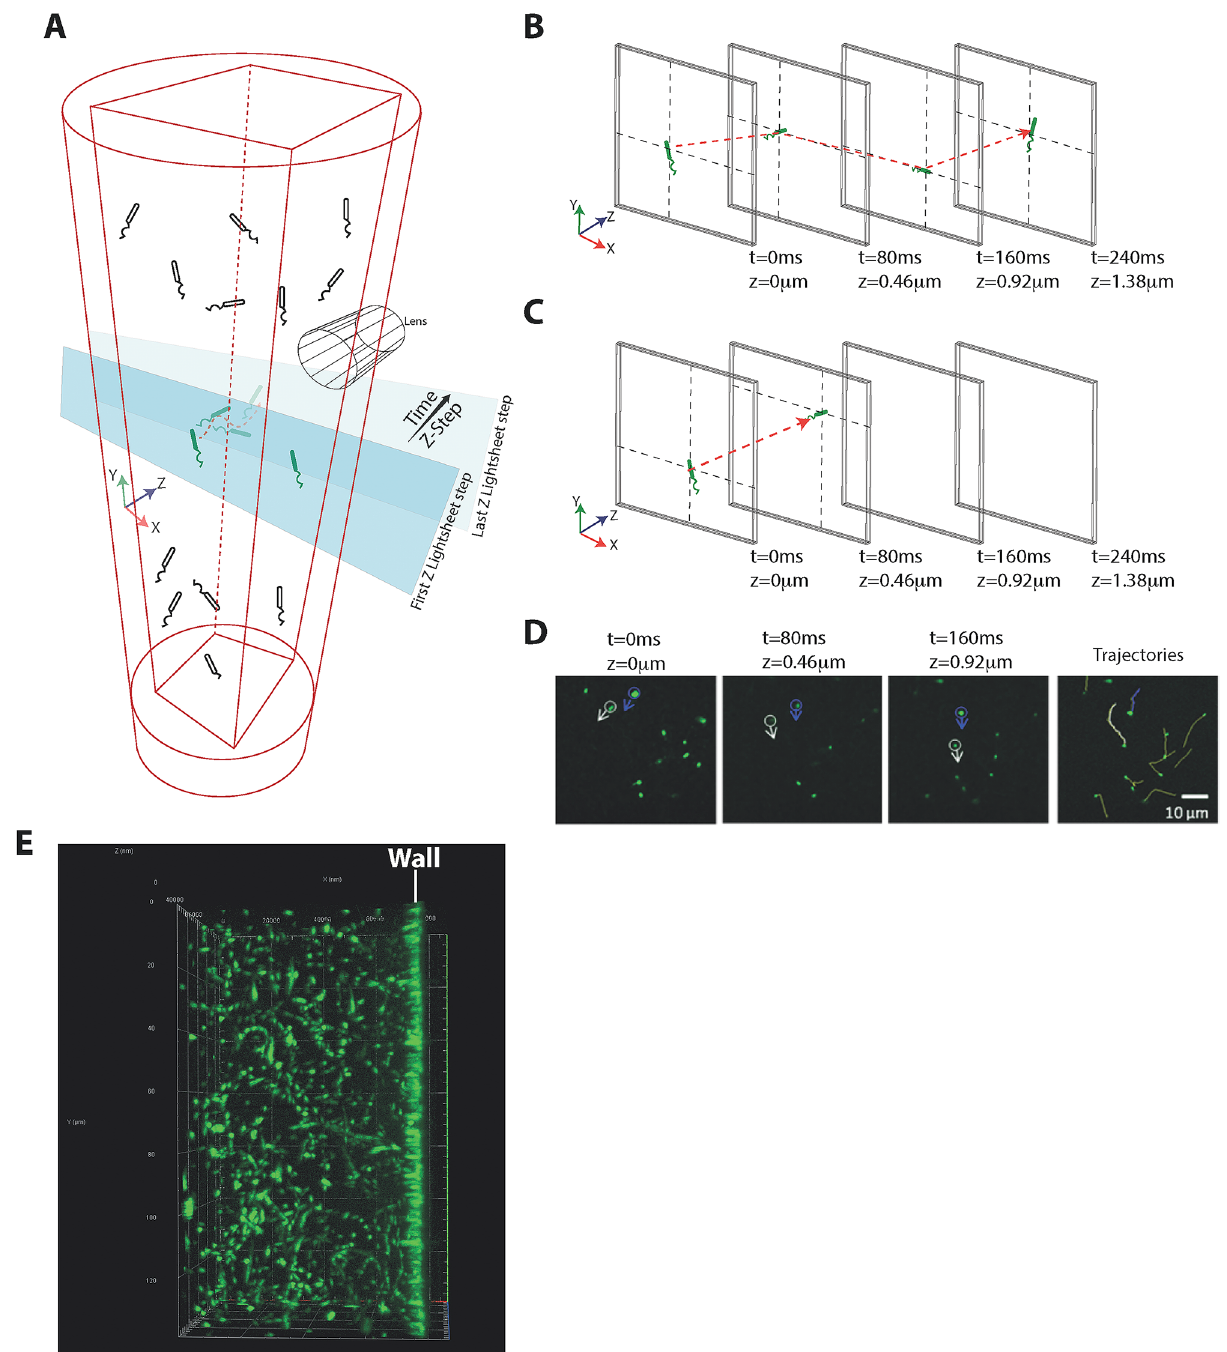
Figure 1. Illustration of light sheet microscopy system setup and design. ( A ) Fluorescence-labeled bacterial cells were loaded into custom made agarose chamber (1% agarose in ABTGC medium that supports biofilm formation). The illumination beam path is orthogonal to the detection beam path. A thin sheet of light is formed at the focal plane of the detection objective. The sample is moved in the z-direction immediately after each acquisition and 3D image of the sample is reconstructed thereafter. ( B ) During light sheet imaging acquisition in the z-direction, the x–y coordinates of bacterial cells in each z-step can be captured while the exposure time (i.e. 80 ms) of each z-step can be used as time intervals. ( C ) During light sheet image acquisition, the trajectory will be cut off with shorter time durations when bacteria turn and swim in a reverse direction. ( D ) Tracking of bacterial cells from the frame by frame analysis. Bacterial cells which appear as “particles” are stitched together to form trajectories using the linear assignment problem (LAP) method after segmentation utilizing the difference of Gaussians approach and filtering based on mean intensity and quality. ( E ) Large field of view of the 3D trajectories of bacteria swimming in the agarose